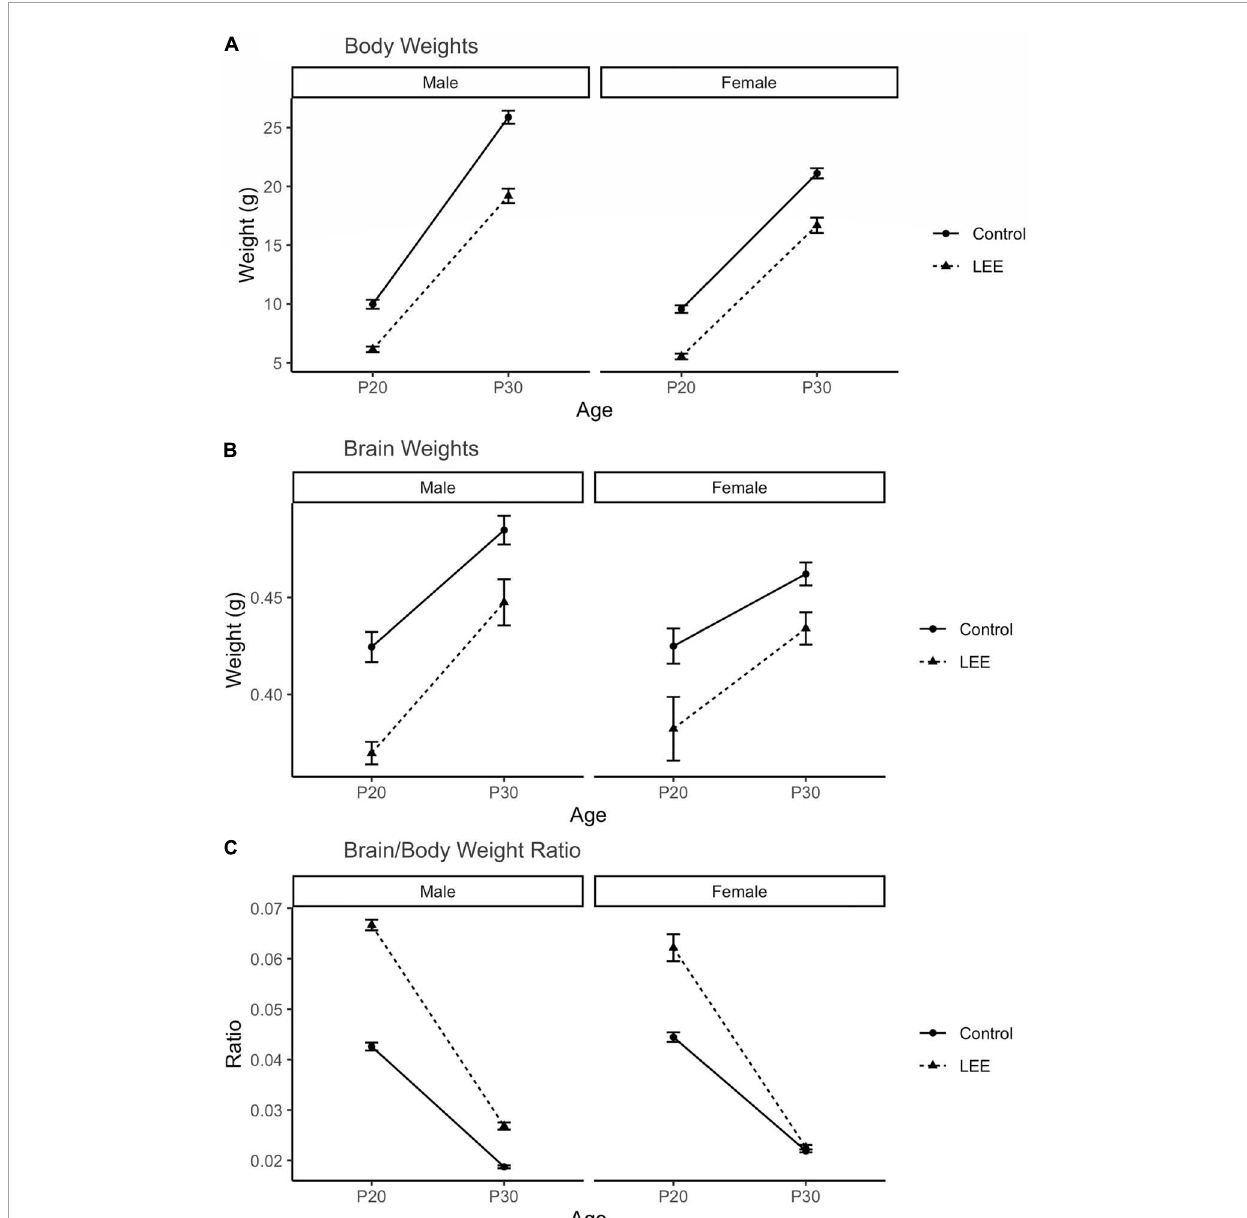
FIGURE3 Offspring measures: Gross development. (A) A significant ( p < 0.001) reduction in body weight for LEE pups was observed in every age and sex group, when compared to controls ( N = 310). (B) Significant reductions in brain weights were observed for LEE males at P20 ( p = 0.003) and P30 ( p = 0.0332) developmental time points. However, significant reductions were only observed in P20 LEE females ( p = 0.0085) and no significance is observed in P30 LEE females ( p = 0.1184) compared to controls ( N = 70). (C) Significant increases to the brain/body ratio are observed in LEE males at both developmental time points. Significant increases to the brain/body ratio were only observed in P20 LEE females and not P30 females as compared to controls ( N = 70). Data expressed as mean ± SEM.